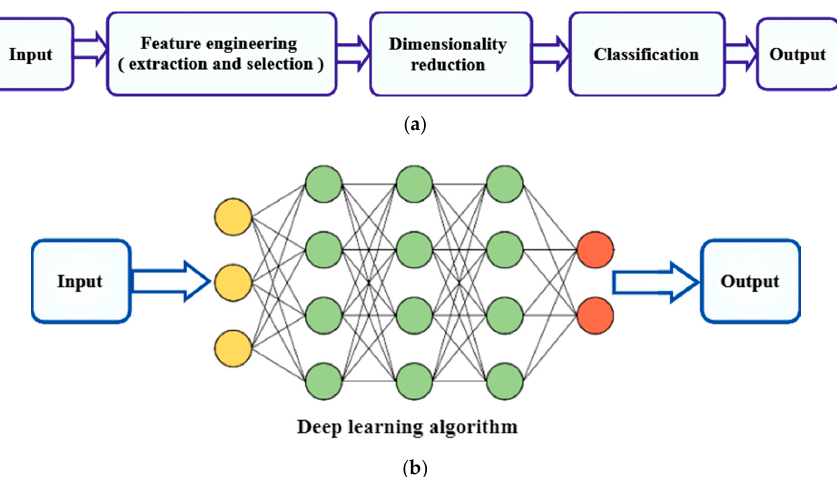
Figure 9. Knee bone segmentation using ( a ) classical machine learning and ( b ) deep learning. Classic machine learning feature architecture includes hand-picked representations and mapping, while deep learning uses multiple hidden layers to extract representations of hierarchical features